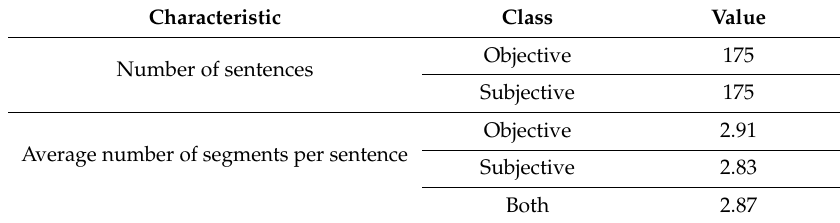
Table 3. Number of sentences and average number of segments per class (subjective /